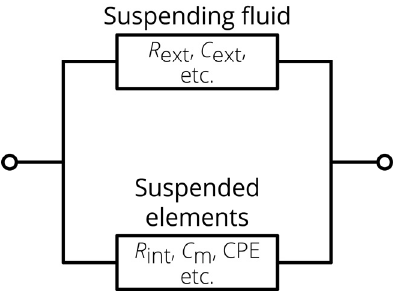
Fig. 1. The basic schematic diagram of many bioimpedance models consisting of parallel branches representing the suspended elements and the suspension in which they rest. In this case R ext and C ext would be the resistance and capacitance of the suspending fluid, respectively and R int , C m , and CPE would be the internal resistance of the suspended elements, the membrane capacitance and a constant phase element of the suspended elements, respectively. However, any components could be used along these